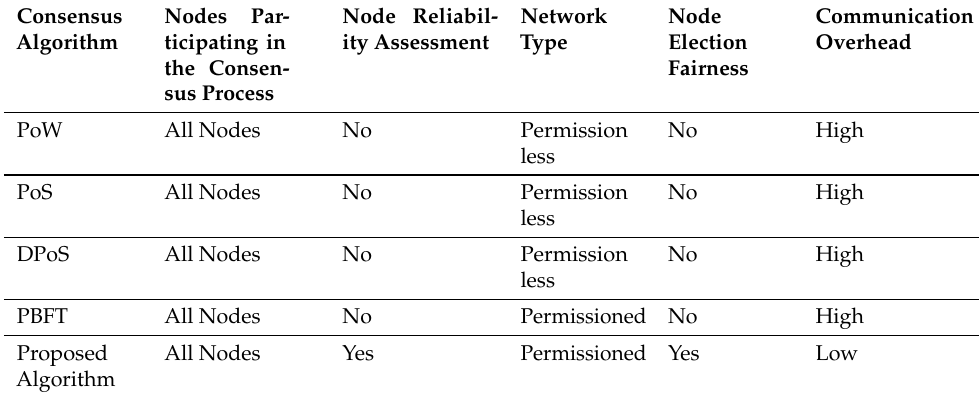
Table 3. Comparative analysis of proposed algorithm with other existing